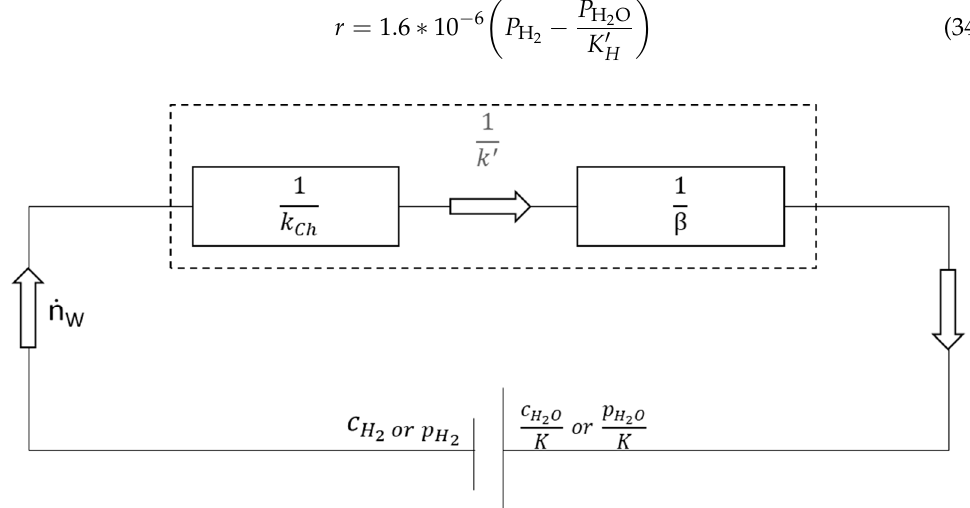
Figure 3. Schematic for the reduction of wüstite with hydrogen. Shown as a replacement diagram for the resistance network of the total reaction considering chemical reaction and mass transport.